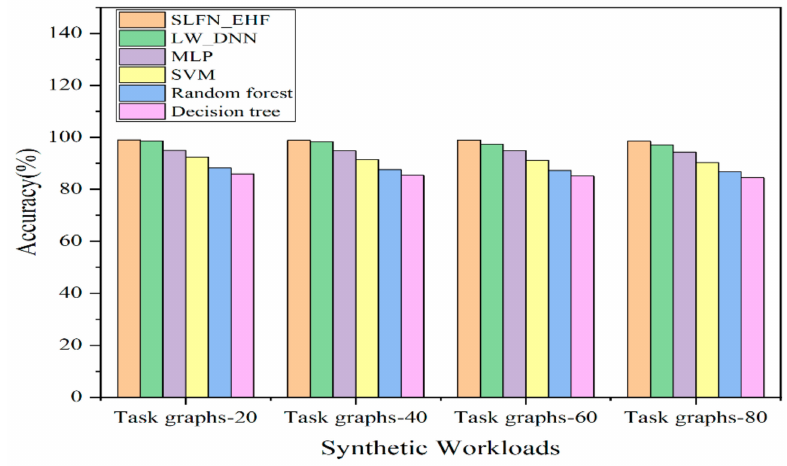
Figure 7. Prediction Accuracy for Synthetic workloads on Hardware Configuration 1.